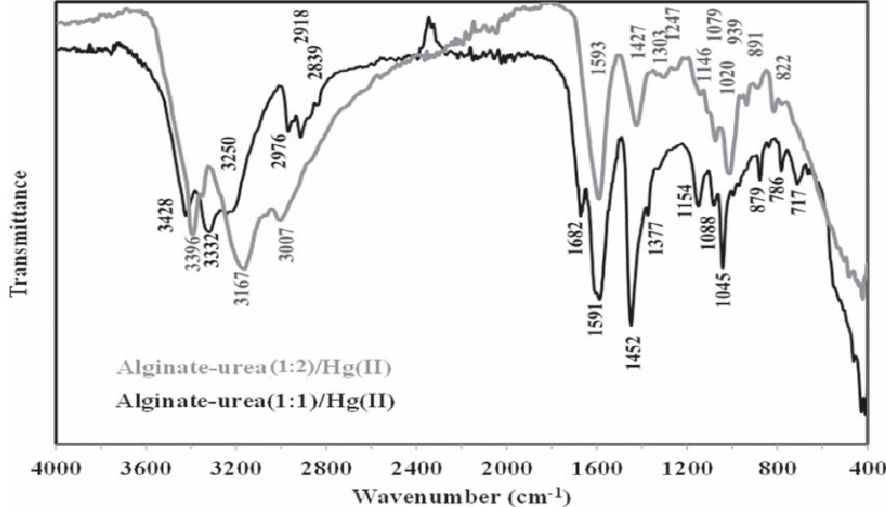
Figure 5. Change in alginate structure after grafting two ratios of urea, (1:1) and (1:2), in order to incorporate amine functions [75].